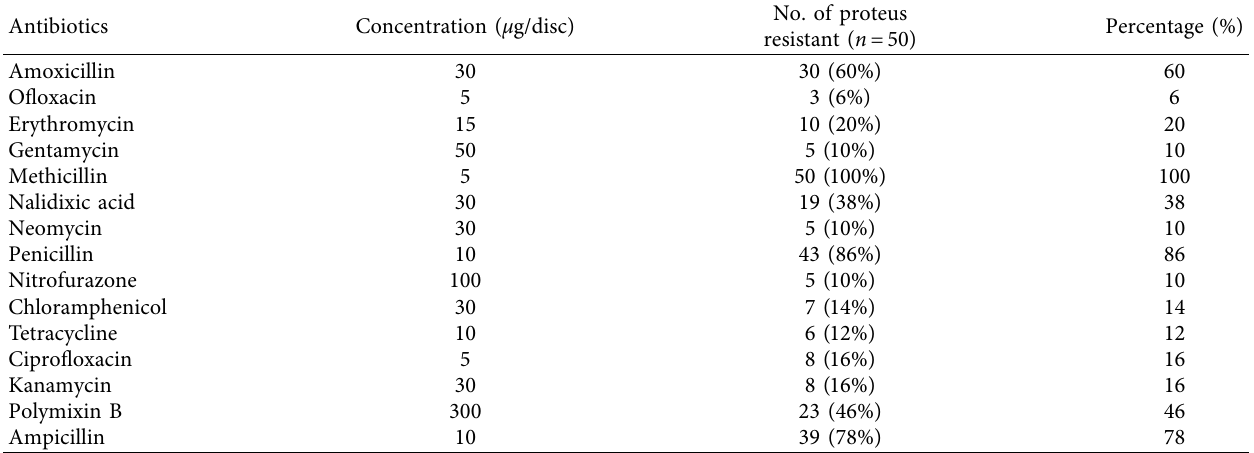
Table 4: Percentage of resistance against antibiotic in P. vulgaris isolated from entire sampling